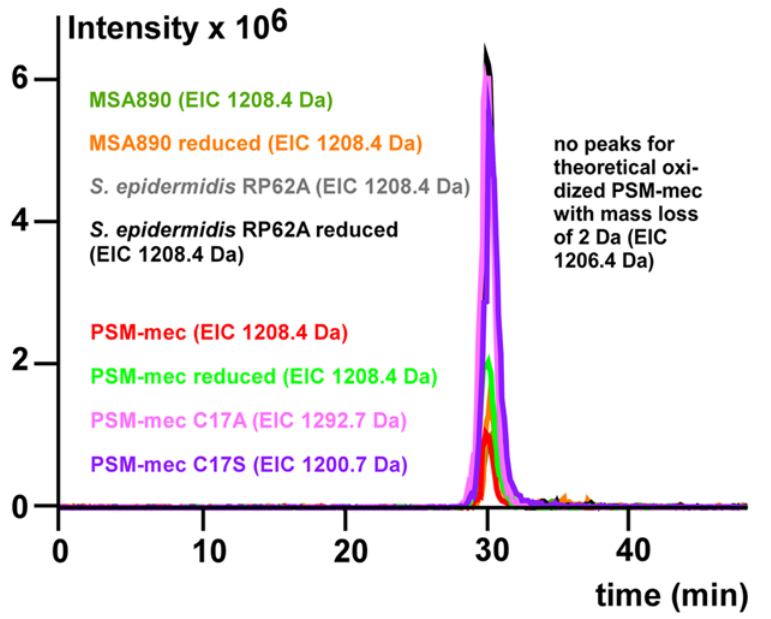
Figure 7. Analysis of PSM-mec dimerization by size exclusion chromatography/mass spectrometry (SEC/ESI-MS). Samples of synthetic PSMs and PSM-mec containing S. aureus or S. epidermidis culture filtrates, with or without reduction performed with 3% mercaptoethanol for 2 h at room temperature, were run on a Superdex HR 10/30 column with isocratic elution using 0.1% TFA/30% acetonitrile. Acid conditions in the elution buffer ascertain stability of the reduced or oxidized status during chromatography. The graphic shows the extracted ion chromatograms (EICs) of the main, double charged ions of the electrospray mass spectra of PSM-mec before and after reduction. No peaks were obtained when plotting EICs for a mass loss of 2 Da (1206.4 Da), as expected for dimeric, oxidized PSM-mec. In addition, extracted ion chromatograms of the alanine and serine subsitution peptides are shown (only one form owing to the absence of an oxidizable cysteine).